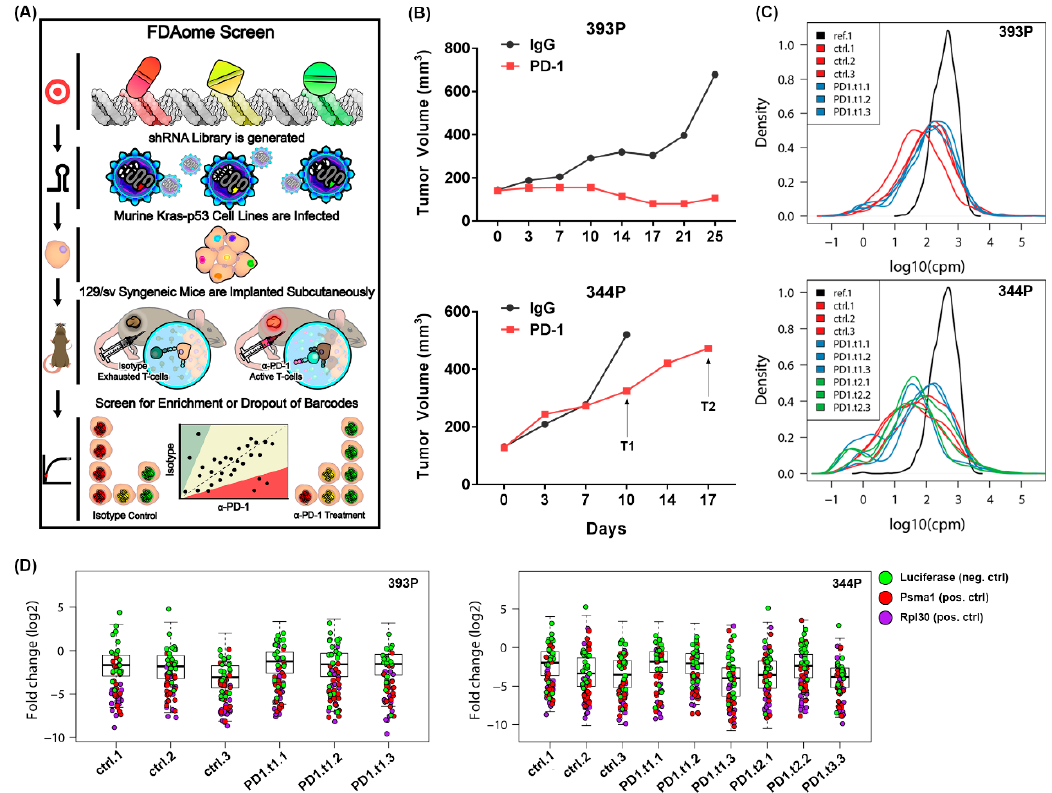
Figure 1. An in vivo functional genomics screen to identify novel tumor survival vulnerabilities when treated with PD-1 blocking antibody. ( A ) Schematic illustrating the workflow of the FDAome short hairpin RNA (shRNA) dropout screen. Briefly, a library of lentiviral particles expressing 10 different barcoded shRNAs for each of 192 genes was transduced into murine Kras/p53 mutant lung cancer cells. Genes included in the library have FDA-approved drugs that target the gene product. These cells were implanted into syngeneic 129/Sv and tumors were treated with PD-1 blocking antibody or IgG control. Tumors were sequenced for barcoded shRNAs and compared to reference cells for enriched or depleted shRNAs between isotype and PD-1 treated tumors. ( B ) 393P epithelial cells and 344P mesenchymal cells used in the FDAome screen were implanted subcutaneously and tumor growth was measured via calipers. T1 indicates time point 1 of tumor collection with PD-1 treatment in the 344P tumors, and T2 indicates time point 2. ( C ) Viral integration distribution of reference population and tumors determined through barcode sequencing (cmp counts per million). Ctrl.1-3 indicate 3 independent IgG treated tumors, and PD1.t1.1-3 label triplicates of anti-PD-1 treated tumors collected at the early time point. PD1.t2.1-3 indicate 344P tumors which were collected 1 week later at time point 2. ( D ) Fold change distribution (log2) of individual tumors relative to the initial transduction references with individual barcodes for positive controls Psma1 (red)/Rpl30 (purple), and the negative control Luc (green). Individual tumor samples per each group (ctrl, PD1.t1, PD1.t2) are shown.